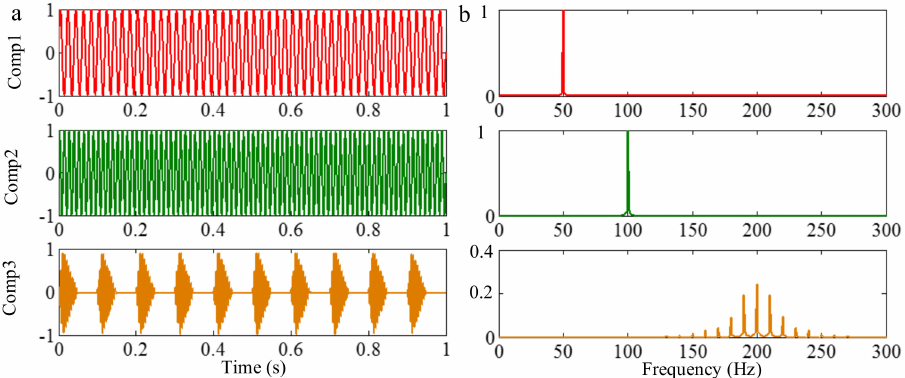
Figure 31. The STFT of the sample signal f sig 7 : ( a ) 2D figure and ( b ) 3D figure.